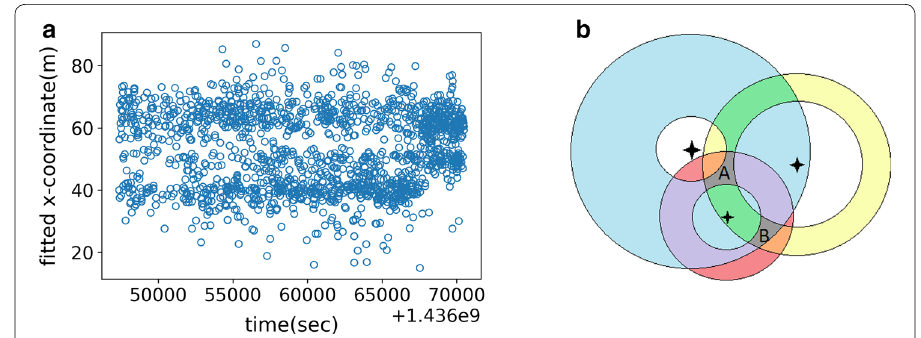
Fig. 2 a Estimation of the x-coordinate in meters of a static MAC device through time; b RSS-based positioning can lead to multiple local